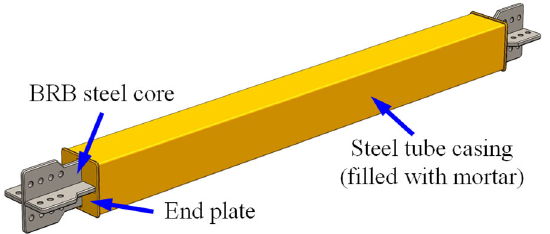
Figure 1. Schematic of the conventional BRB.